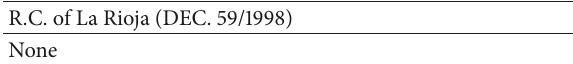
Table 17: Species included in the regional catalogue (R.C.) of La Rioja (DEC. 59/1998).